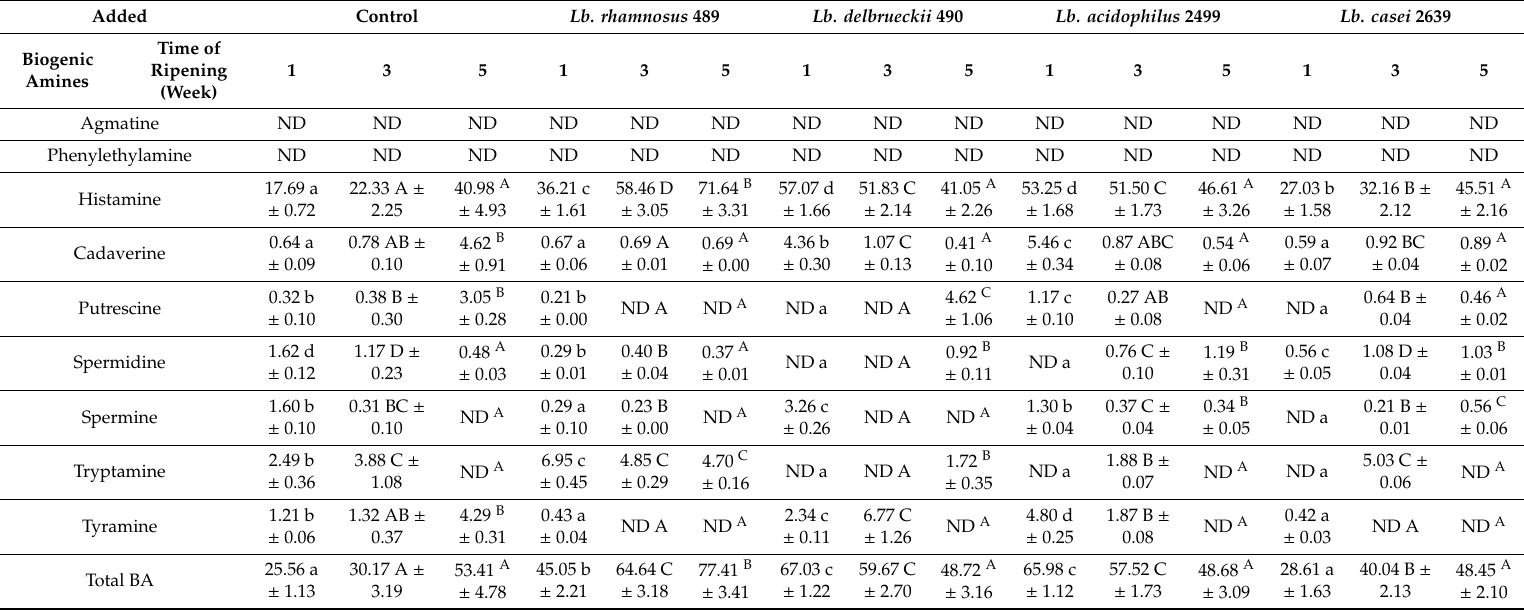
Table 2. Concentration of biogenic amines (BAs) in Dutch-type cheese models during ripening (mg kg − 1